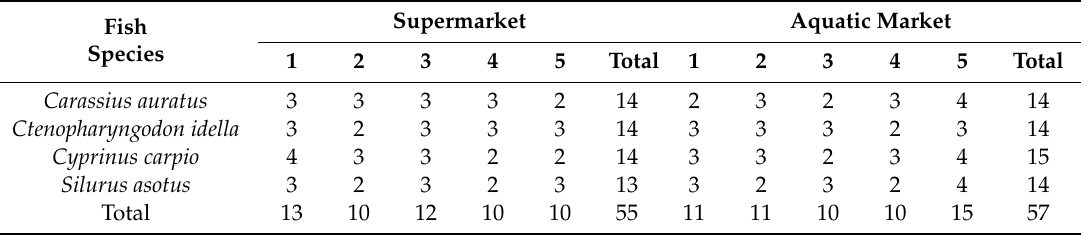
Table 2. Species, quantity, and origin of fish sampled in summer. Fish Species Ctenopharyngodon